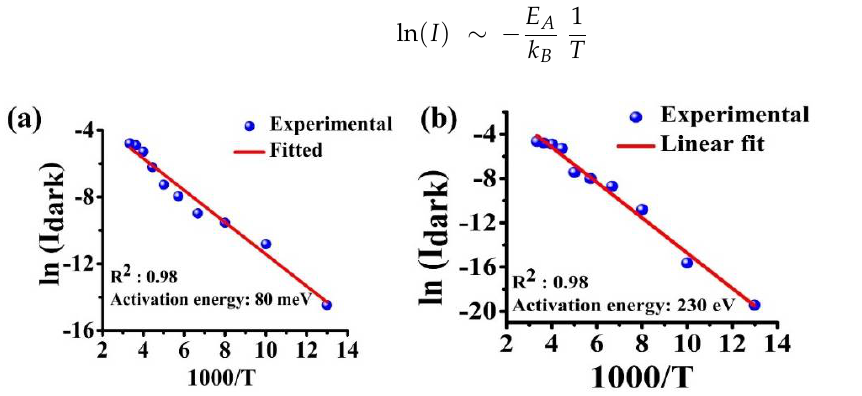
Figure 5. Temperature dependence of dark current at 0.2 V forward bias in ( a ) as-grown and ( b ) In-situ annealed Te-doped GaAs NWs.